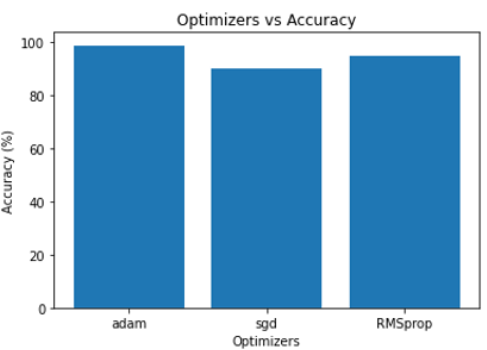
Figure 9. Optimizers used and their corresponding Accuracy.